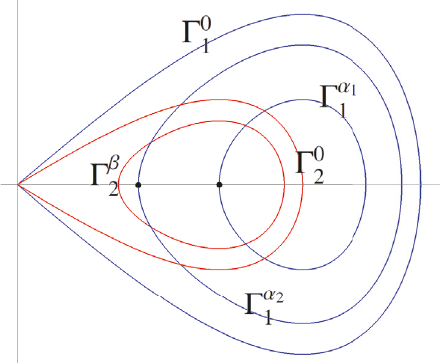
Figure 2: The present figure describes our geometric construction. The points on the 𝑥 -axis marked with a black circle (from right to the left) represent (𝑎 1 , 0) and (𝑎 2 ,0) on the orbits Γ 𝛼 1 1 and Γ 𝛼 2 1 . For this figure we have considered 𝑓(𝑥) = 𝑥 3 and 𝑉 1 = 2 , 𝑉 2 = 1. For graphical reasons a slightly different 𝑥 - and 𝑦 -scaling has been